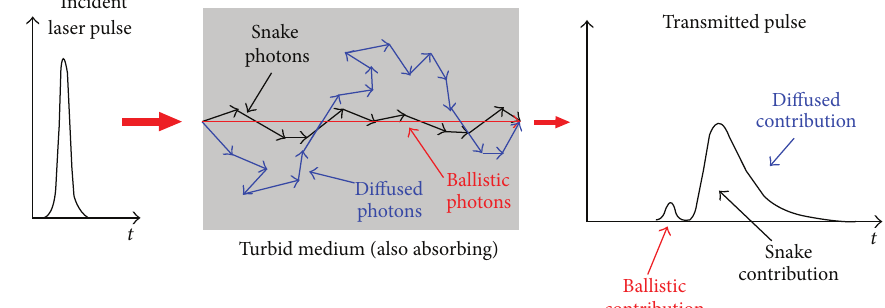
Figure 4: Transmitted pulse representing the photons time-of-flight distribution (TPSF) measured following injection of an ultrashort laser pulse into a turbid medium (scattering and